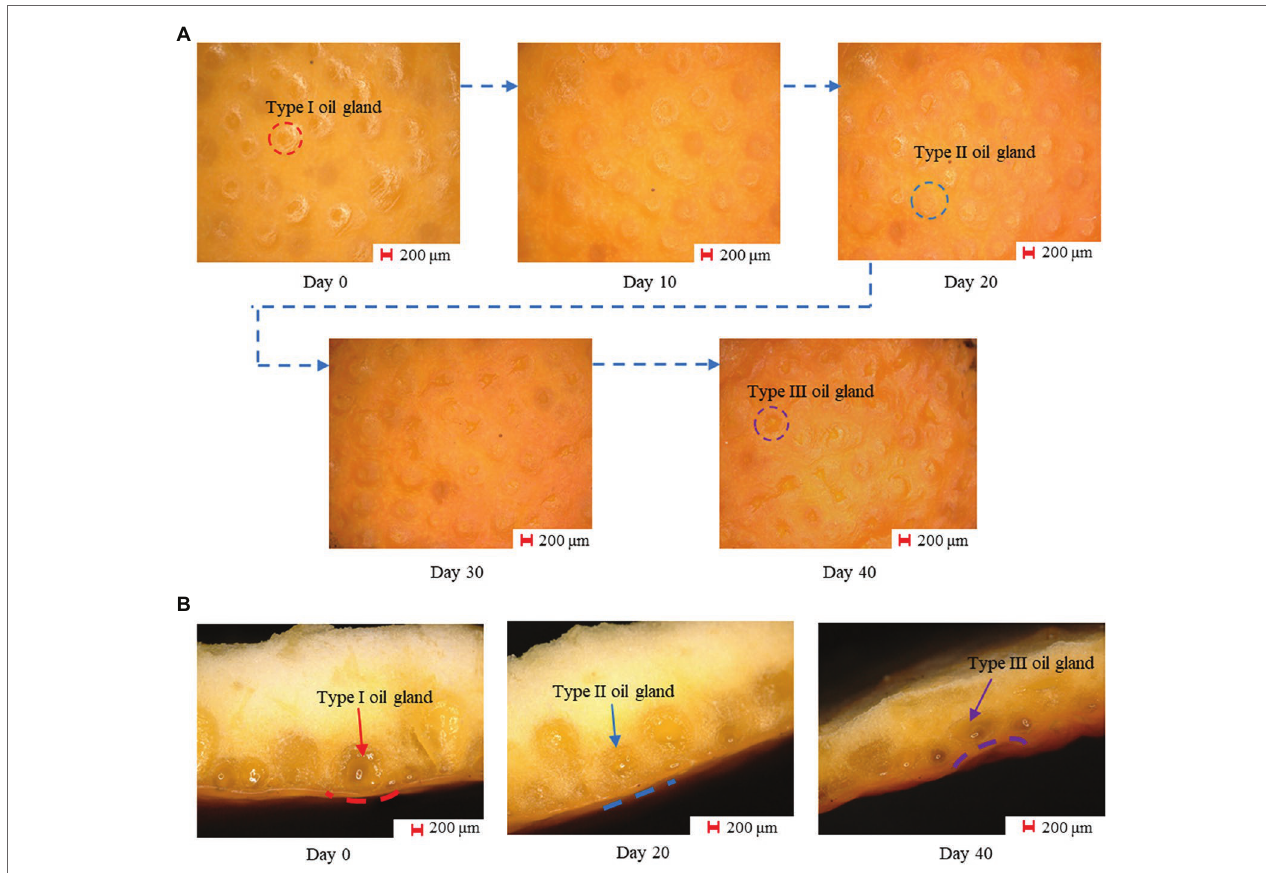
FIGURE 4 | (A) The images captured in different storage periods. An increasing number of Type I oil glands turned into Type II and III glands with increasing storage time, and most of the glands were Type III glands on day 40. (B) The cross-section of the rinds on day 0, 20, and 40, on which different types of oil glands can be